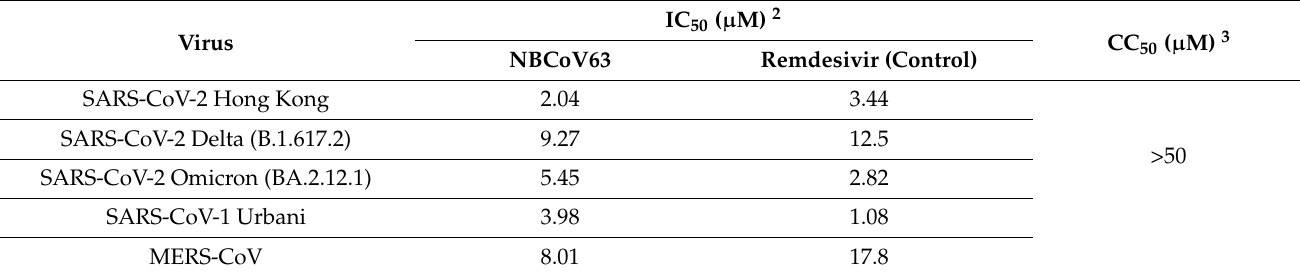
Table 7. Antiviral activity of NBCoV63 against authentic viruses 1 in Calu-3 cells.